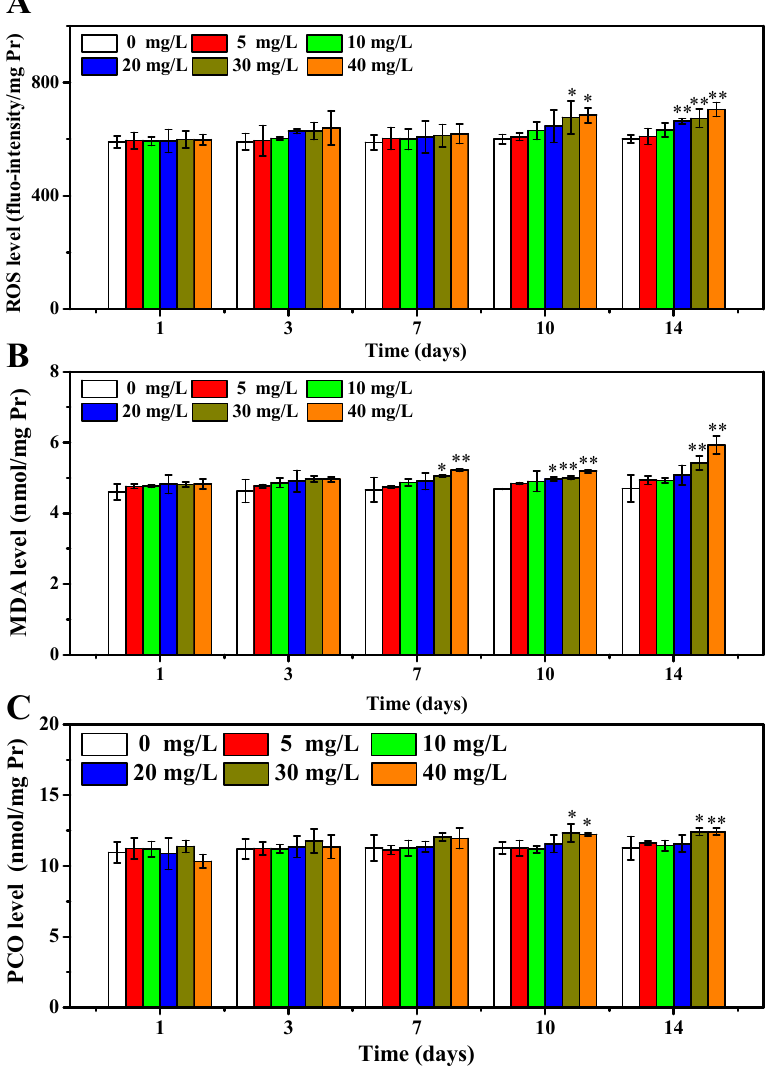
Figure 5. ( A ) ROS level of zebrafish, ( B ) MDA concentration of zebrafish, ( C ) PCO concentration of zebrafish after exposure to OCNPs in subacute toxicity test. *, ** indicate significant differences ( p < 0.05) and remarkably significant differences ( p < 0.01) among treatments.